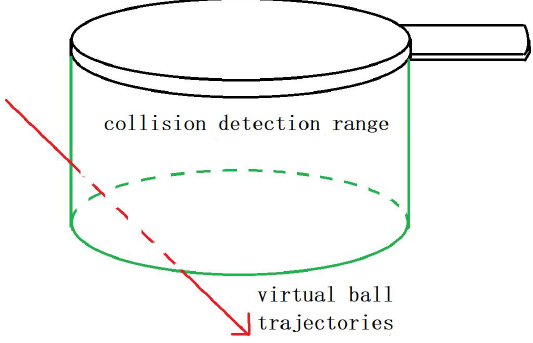
Figure 8. Collider error